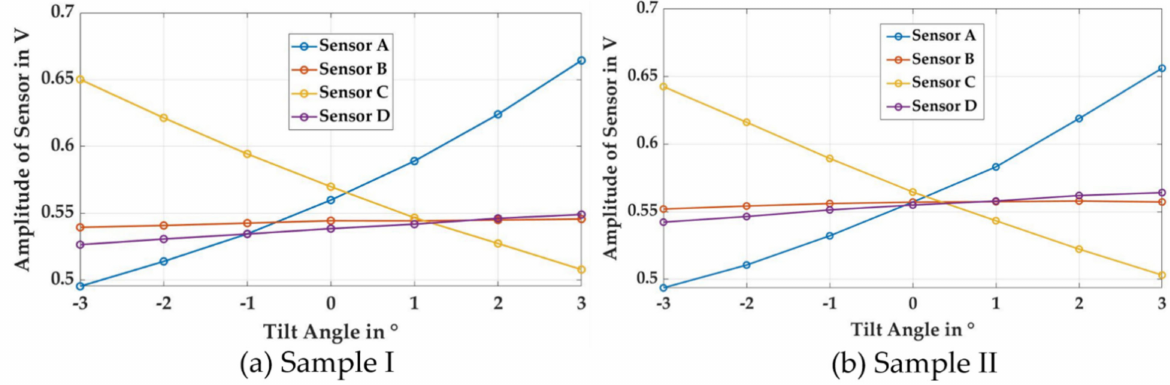
Figure 6. Effect of tilting on sensor readings for the cases of ( a ) strong anisotropy and ( b ) weak